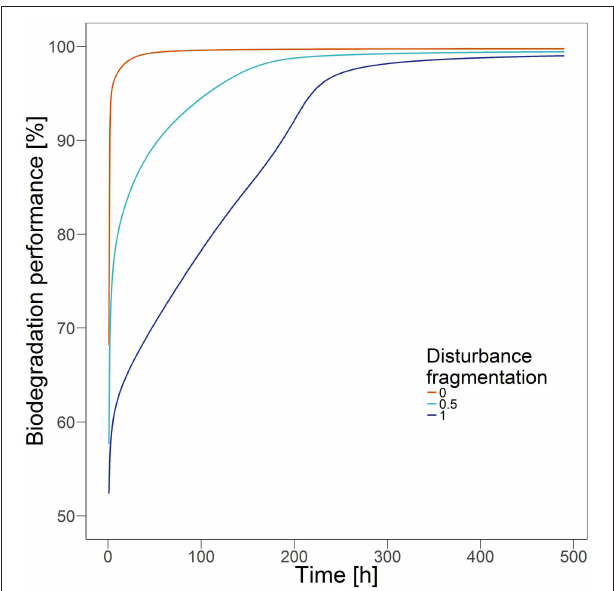
FIGURE 2 | Biodegradation performance over time after single disturbance events with fragmentation parameter of 0, 0.5, and 1 and disturbance size of